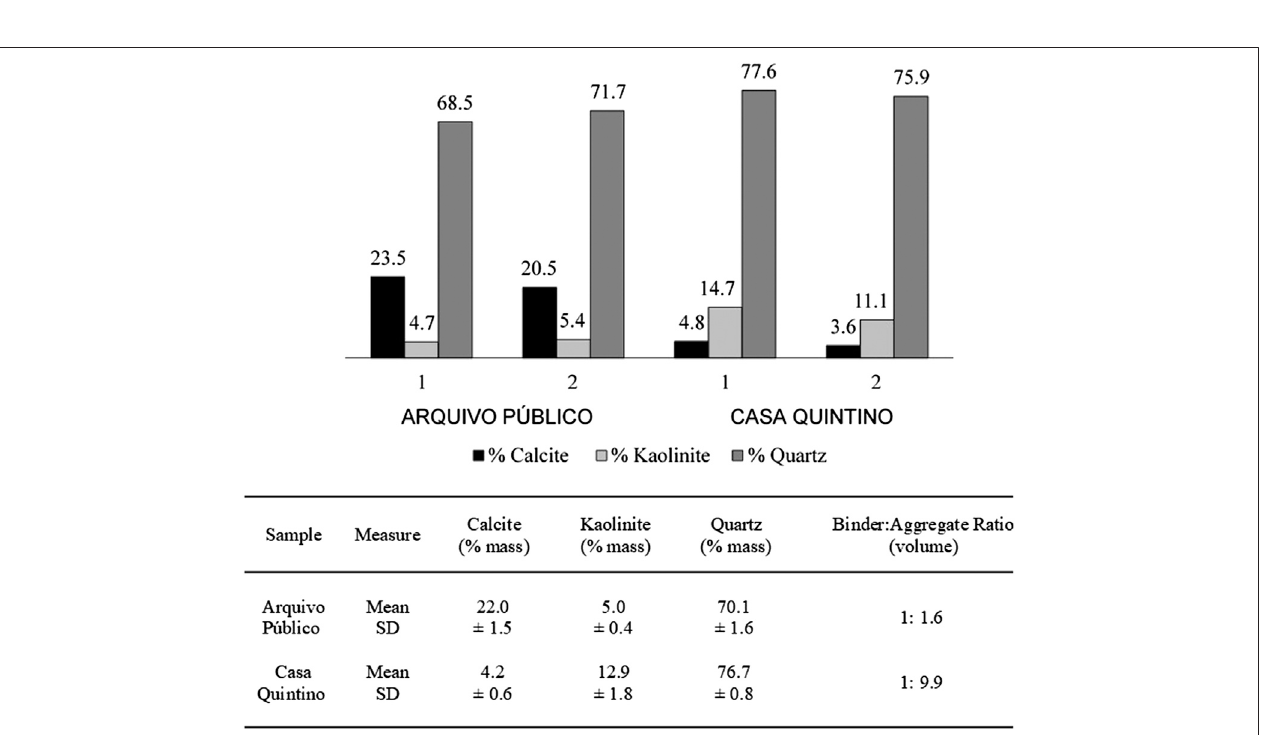
FIGURE 6 | Percentage of binder and aggregate identi fi ed by rational calculation.